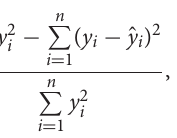
Figure 9A and SampEn in Figure 9B during the development of muscle